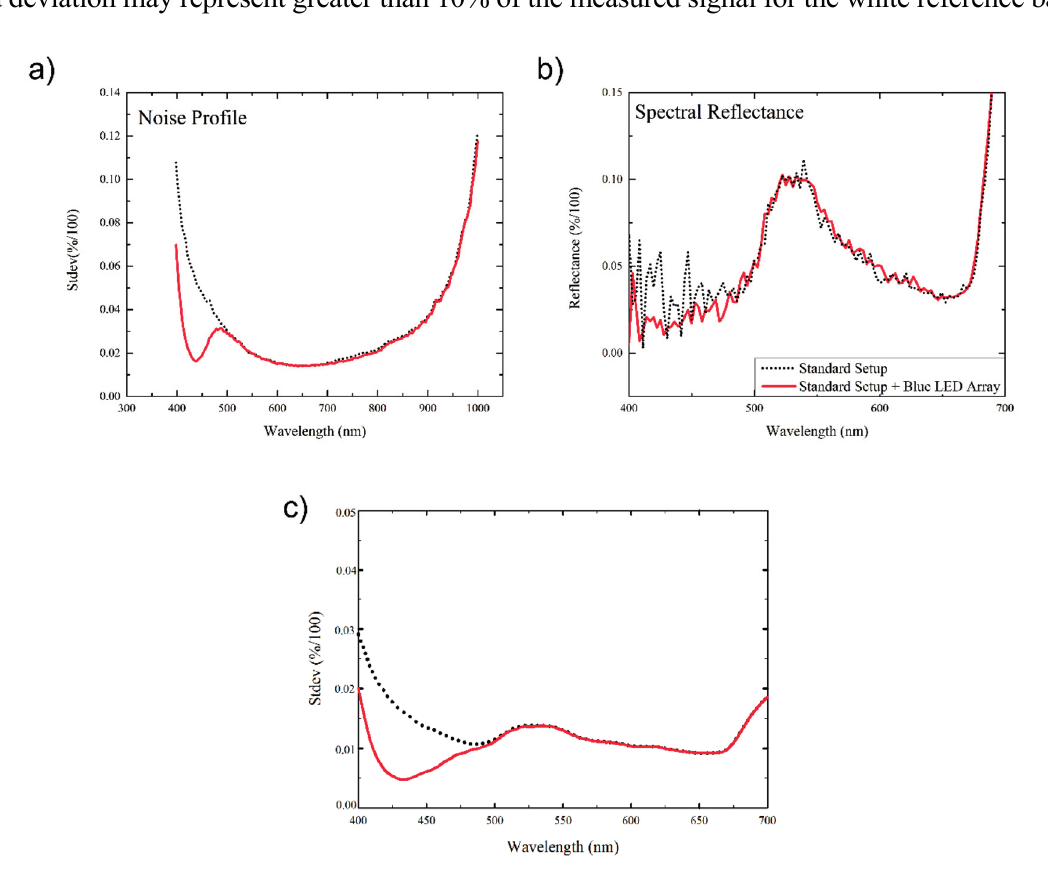
Figure 2. ( a ) Noise profile of the hyperspectral measurement system in reflectance wavebands from 400–1000 nm (the black dotted line indicate the standard setup, the red line the standard setup with the additional blue LED-array); ( b ) spectral reflectance profile of healthy sugar beet leaf tissue in the VIS from 400–700 nm and ( c ) standard deviation of the reflectance of 15,000 pixel of healthy sugar beet leaves without (dotted black line) and with (solid red line) additional illumination by the LED-array. (Best viewed in